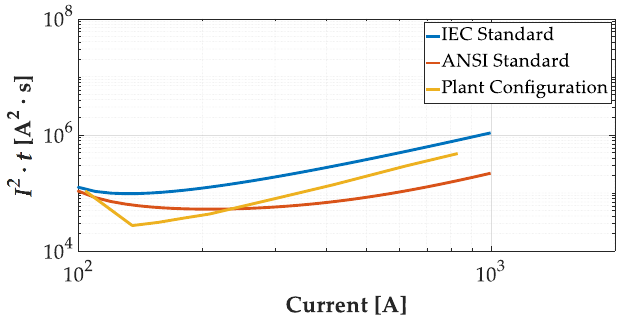
Figure 8. Proposed overcurrent relay 50/51 model.